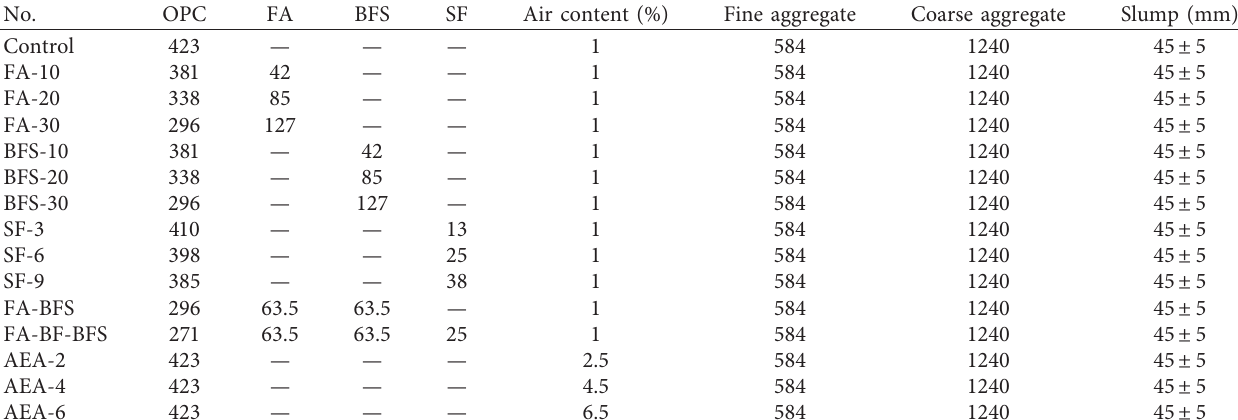
Table 1: Mix proportions of concretes with multiadmixtures (kg/m 3